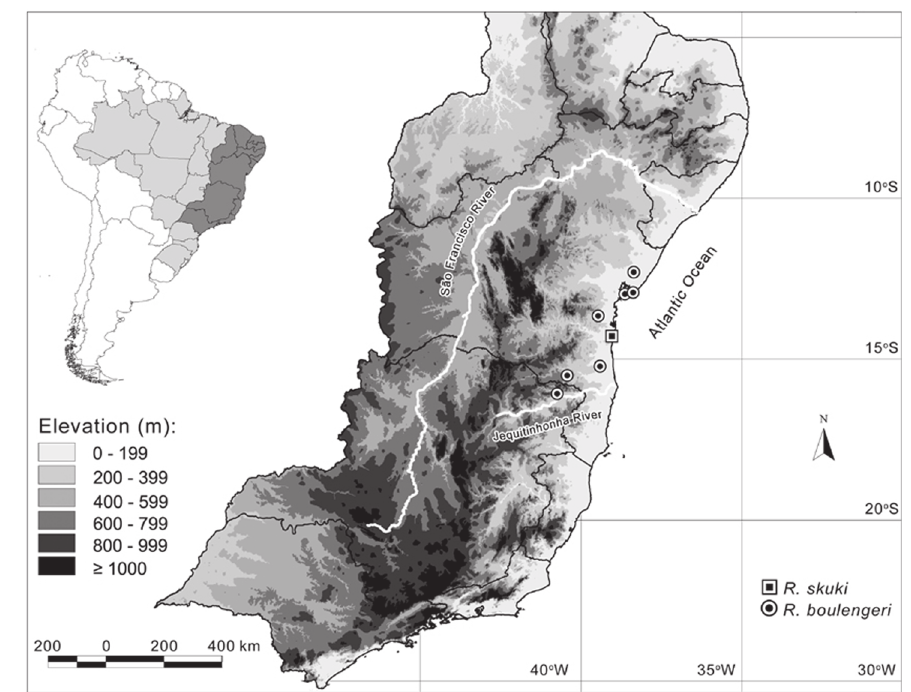
Figure 13. Geographic distribution of Rhinella skuki sp. nov. (square) and R. boulengeri